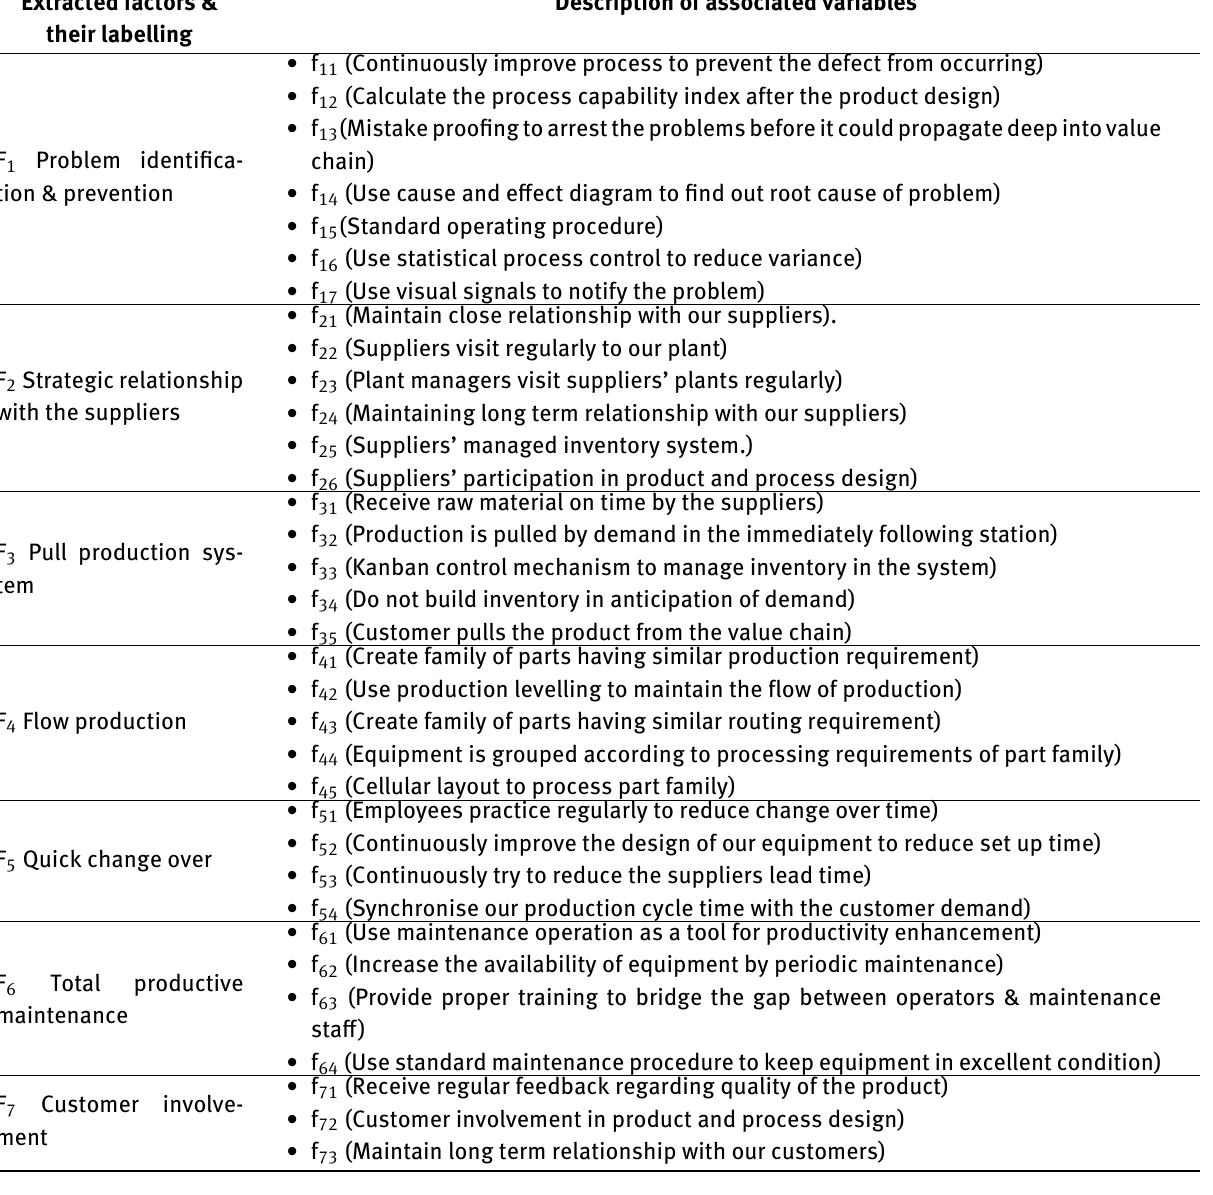
Description of associated